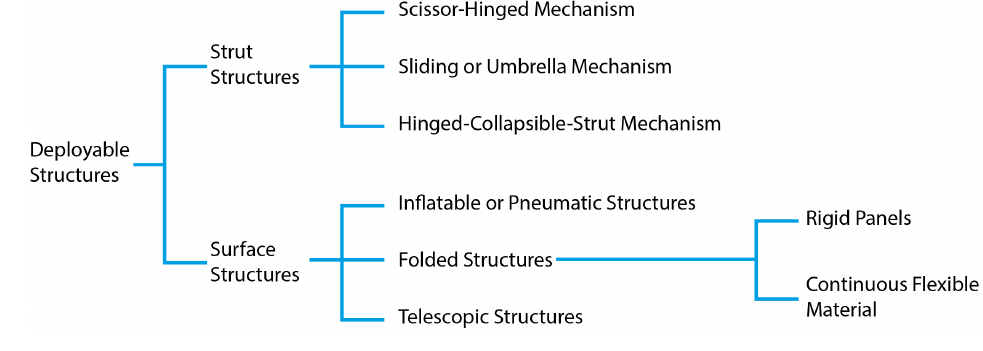
Figure 4: Merchan’s classification of deployable structures from 1987